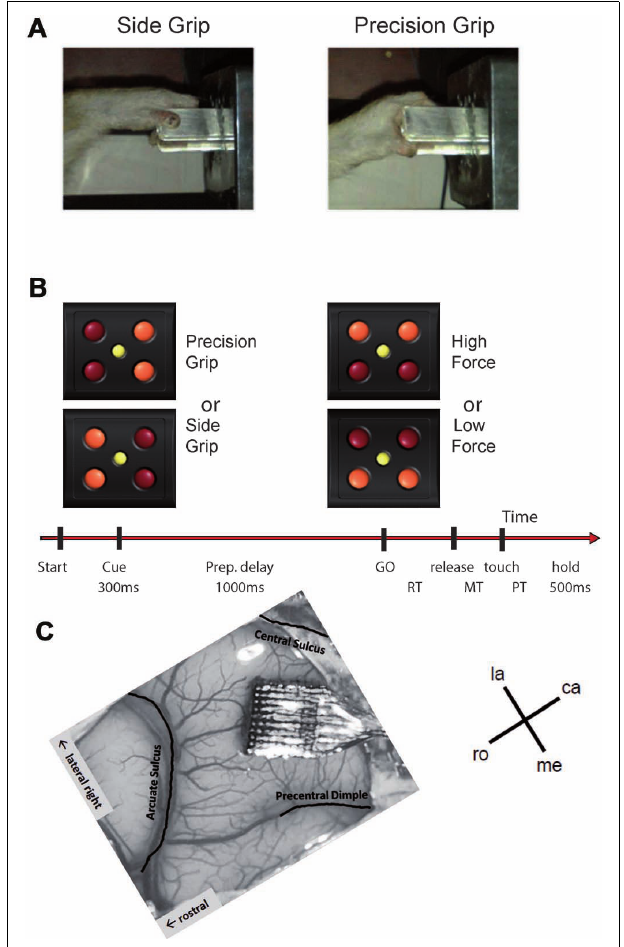
FIGURE 1 | (A,B) Experimental design (see text for details). (C) Implanted Utah array in the motor cortex of our monkey.The picture is rotated such that the array is oriented in the same way as the maps shown in Figures 4, 8, and 9 . la, lateral; me, medial; ro, rostral; ca,